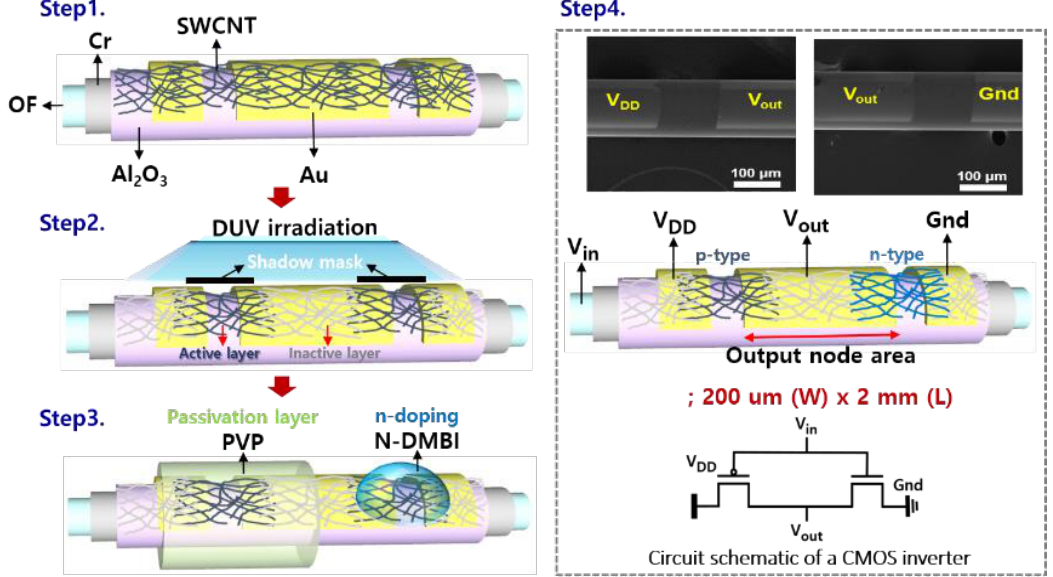
Figure 1. Schematic of fabrication process and scanning electron microscope (SEM) images of the fiber-based SWCNTs (single-walled carbon nanotubes) CMOS inverter circuit.